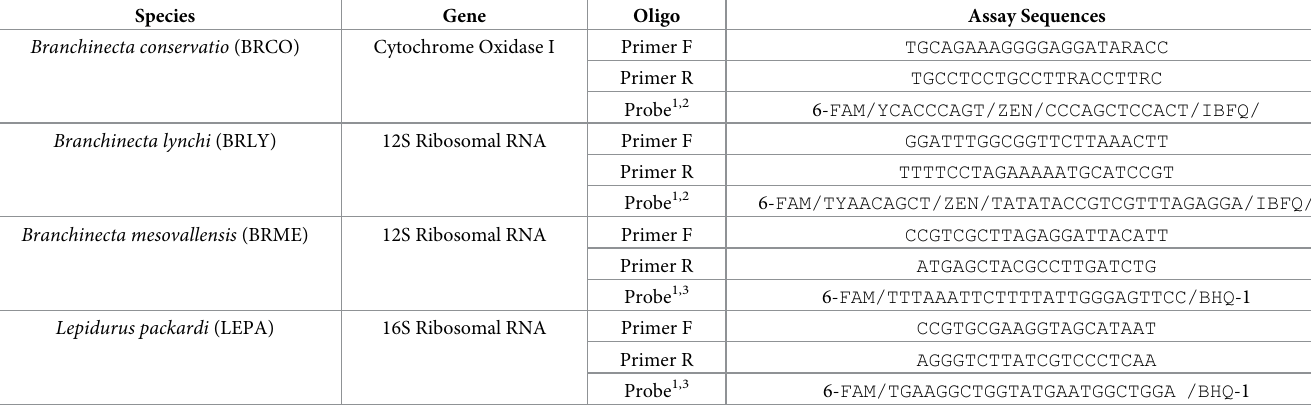
Table 1. The complete DNA sequences of the primers and probes used in each species-specific assay. Species